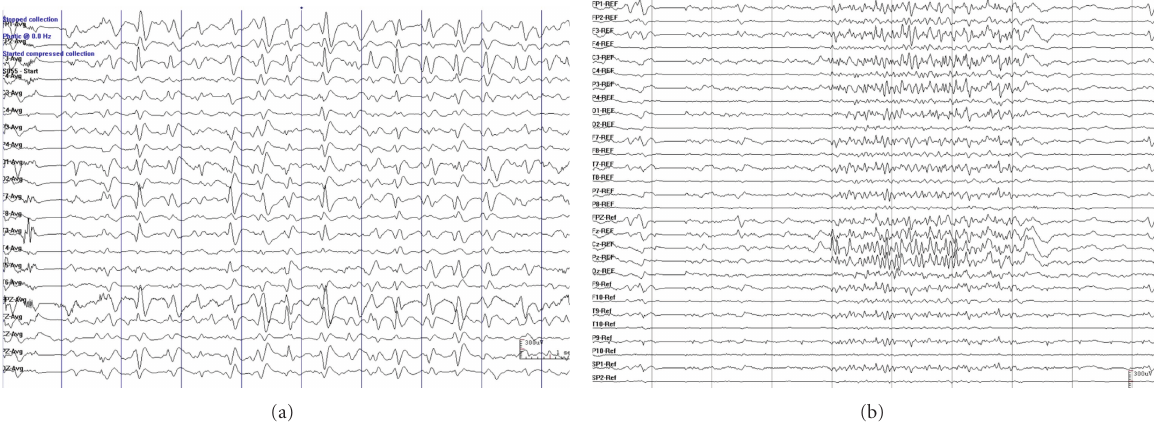
Figure 1: Representative EEGs showing slow spike-and-wave hemispheric dominance and PFA hemispheric dominance characterized by that the amplitude of epileptiform discharges in one hemisphere is higher than that of the other hemisphere (Figures 1(a) and 1(b)) and that the onset of the epileptiform discharges in one hemisphere is earlier than that of the other (Figures 1(a) and 1(b)), as well as that the duration of the epileptiform discharges in one hemisphere is shorter than that of the other (Figure 1(a)). Data were from patient no. 2 in Tables 1 and 2.